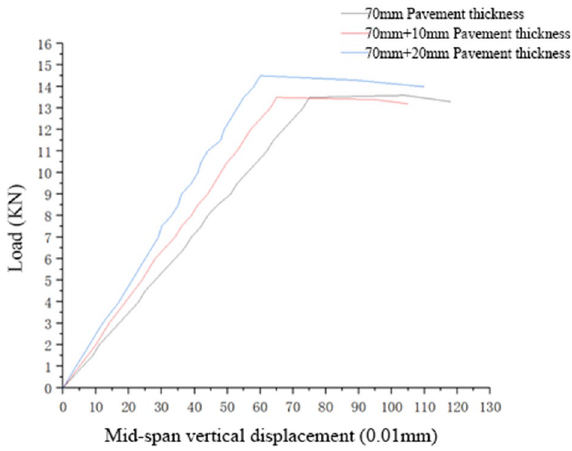
Figure 8. Load–displacement curves of double-layer pavement structures with different pavement thicknesses under the simulated action of a negative bending moment.